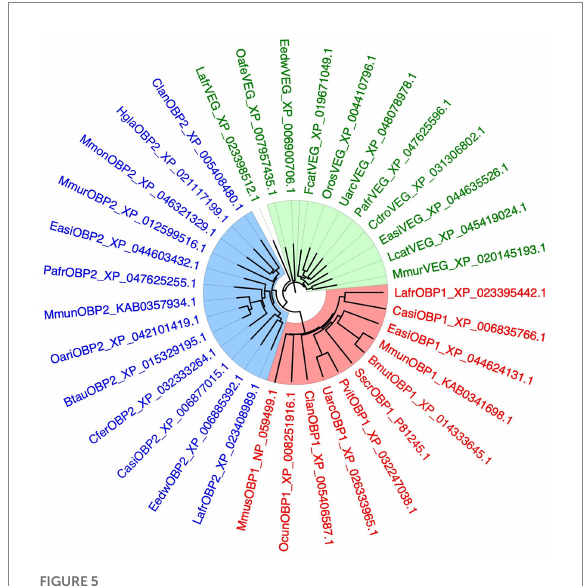
FIGURE 5 Phylogenetic tree of OBP1, OBP2, and VEG from the African elephant, Loxodonta africana (Lafr), and orthologues from other mammalian species. The three proteins have been used in separate BLAST searches and the best hits were downloaded and used to build the tree. The three groups of proteins segregate into separate clades, indicating that LafrOBP2 and its orthologues represent a sub-class of proteins well distinct from the VEGs. Different lipocalins are shown in different colours. Bmut, Bos mutus ; Btau, Bos taurus; Casi, Chrysochloris asiatica ; Cdro, Camelus dromedarius ; Cfer, Camelus ferus ; Clan, Chinchilla lanigera ; Easi, Equus asinus ; Eedw, Elephantulus edwardii ; Fcat, Felis catus ; Hgla, Heterocephalus glaber ; Mmon, Marmota monax ; Mmun, Muntiacus muntjac ; Mmur, Microcebus murinus ; Mmus, Mus musculus; Oafe, Orycteropus afer afer ; Oari, Ovis aries; Ocun, Oryctolagus cuniculus ; Oros, Odobenus rosmarus ; Pafr, Phacochoerus africanus ; Pvit, Phoca vitulina ; Sscr, Sus scrofa; Uarc, Ursus arctos